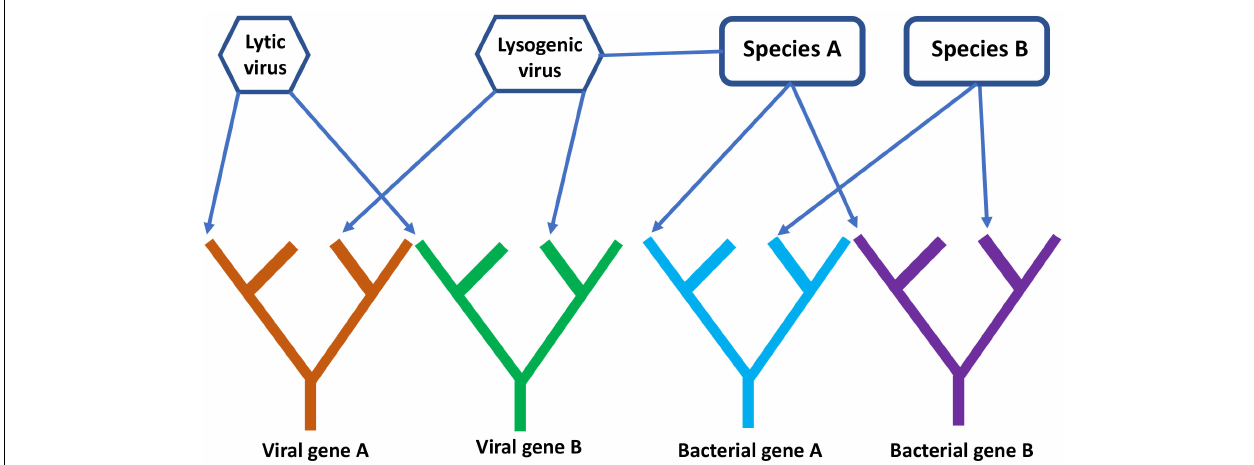
FIGURE 7 | A simple diagram of the phylogenetic forest of gene trees with network components linking different genes together. The diagram shows four gene lineages, two viral and two cellular. Arrows connect genes present on the same genome to their respective viral or bacterial species, while the lysogenic virus is connected to species A, showing that it is a prophage whose genes reside on the same genome as species